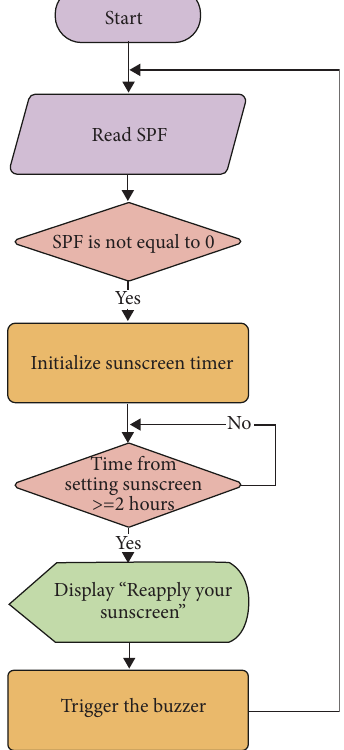
Figure 7: Flowchart of designed algorithm to remind user to reapply